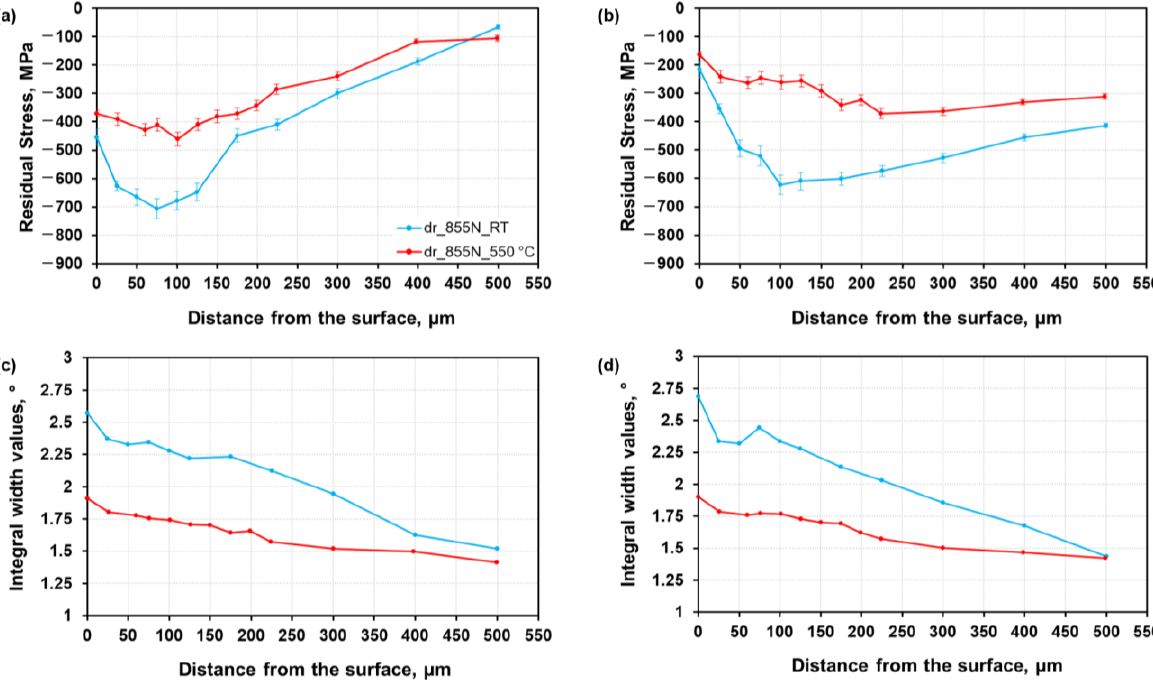
Figure 3. Residual stress profiles and integral width values in longitudinal (( a ) + ( c )) and circumferential (( b ) + ( d )) directions plotted as a function of deep rolling temperatures at constant deep rolling force. Data of the condition deep rolled at RT using a deep rolling force of 855 N were recompiled from [39].